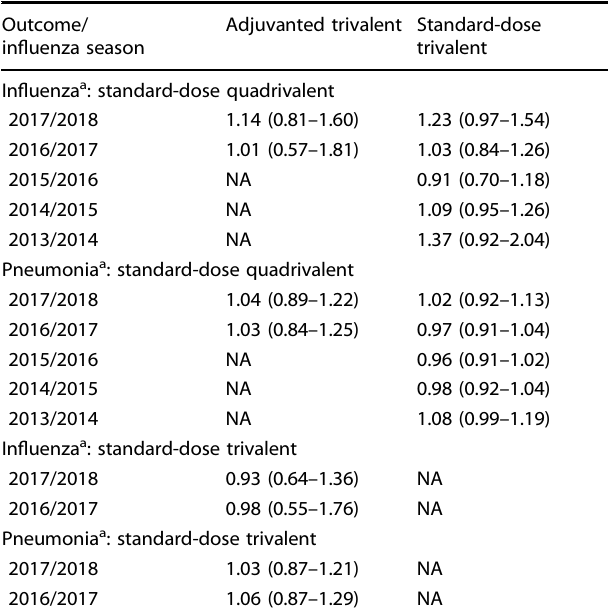
Table 3. Adjusted hazard ratios and 95% con fi dence intervals for outcomes in pairwise comparisons (reference groups are indicated in the